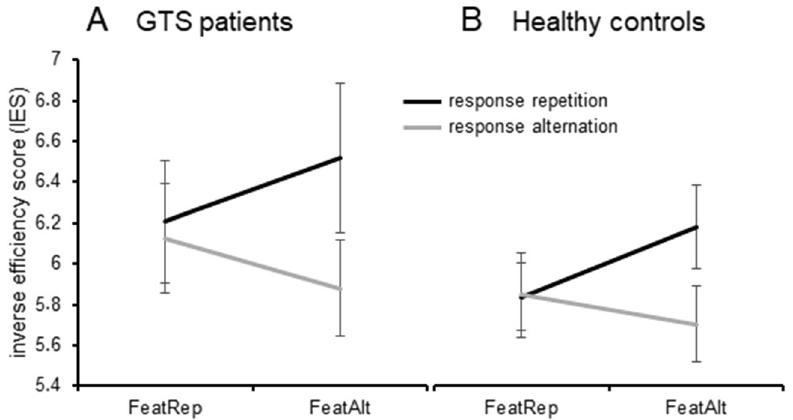
Figure 1. Behavioral data (inverse efficiency score) demonstrating the interaction of Response × Finger compatibility for GTS patients ( A ) and healthy controls ( B ). The IES is illustrated separately for GTS patients ( A ) and healthy controls ( B ) for response repetition and response alternation in the feature (finger) repetition (FeatRep) condition and the feature (finger) alternation (FeatAlt) condition. Error bars represent the standard error of the mean